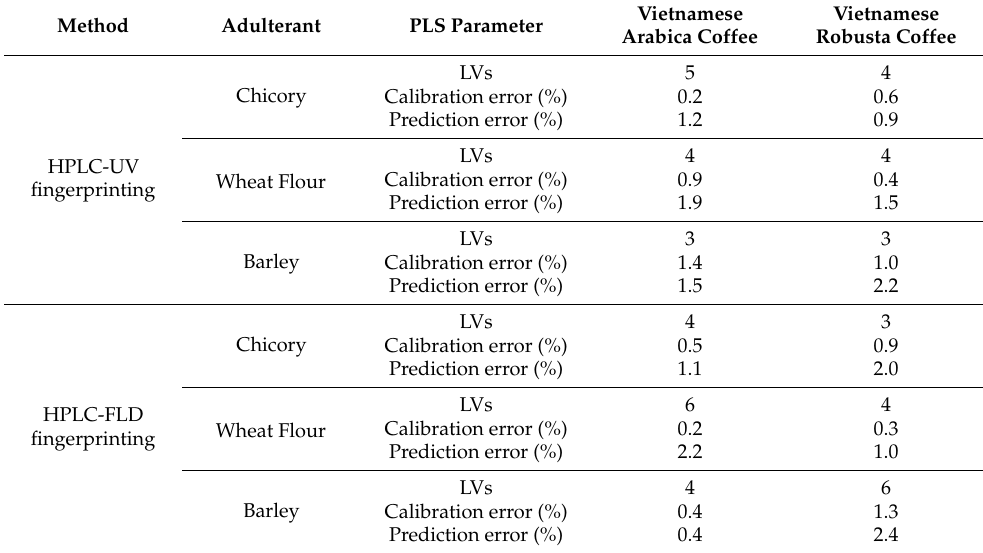
Table 3. PLS results for the six adulteration cases studied based on Vietnamese Arabica and Viet- namese Robusta coffees adulterated with chicory, wheat, flour, and